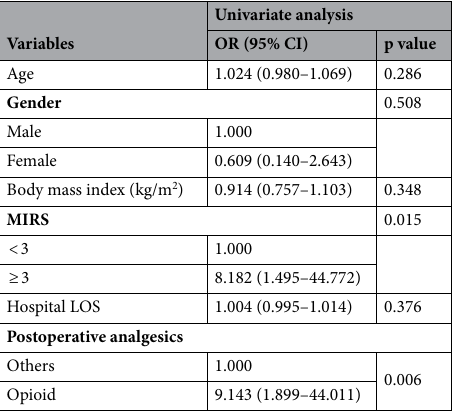
Table 3. Univariate regression analysis associated with postoperative complications in patients with a myotonic dystrophy type 1. Data are expressed as odds ratio (95% confidence interval). MIRS muscular impairment rating scale, LOS length of stay, Others nonsteroidal anti-inflammatory drugs, acetaminophen, nefopam, and no